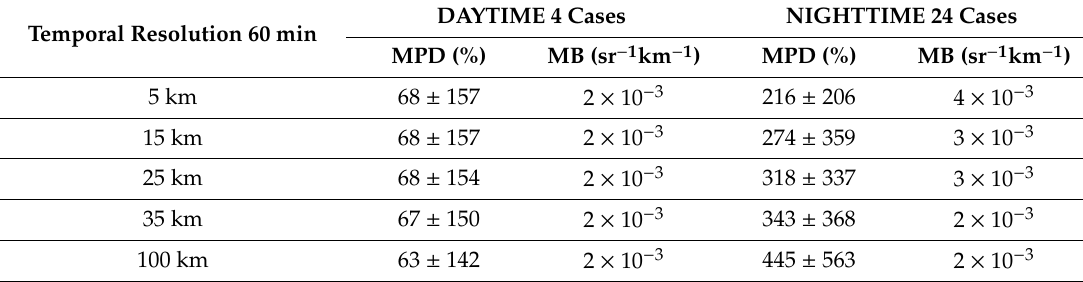
Table 4. Statistical results (MPD and MB) derived from simultaneous measurements between CALIOP and Harzgerode data for the 14 daytime and 16 nighttime cases considering di ff erent along–track averages in CALIOP data (5 km, 15 km, 25 km, 35 km, and 100